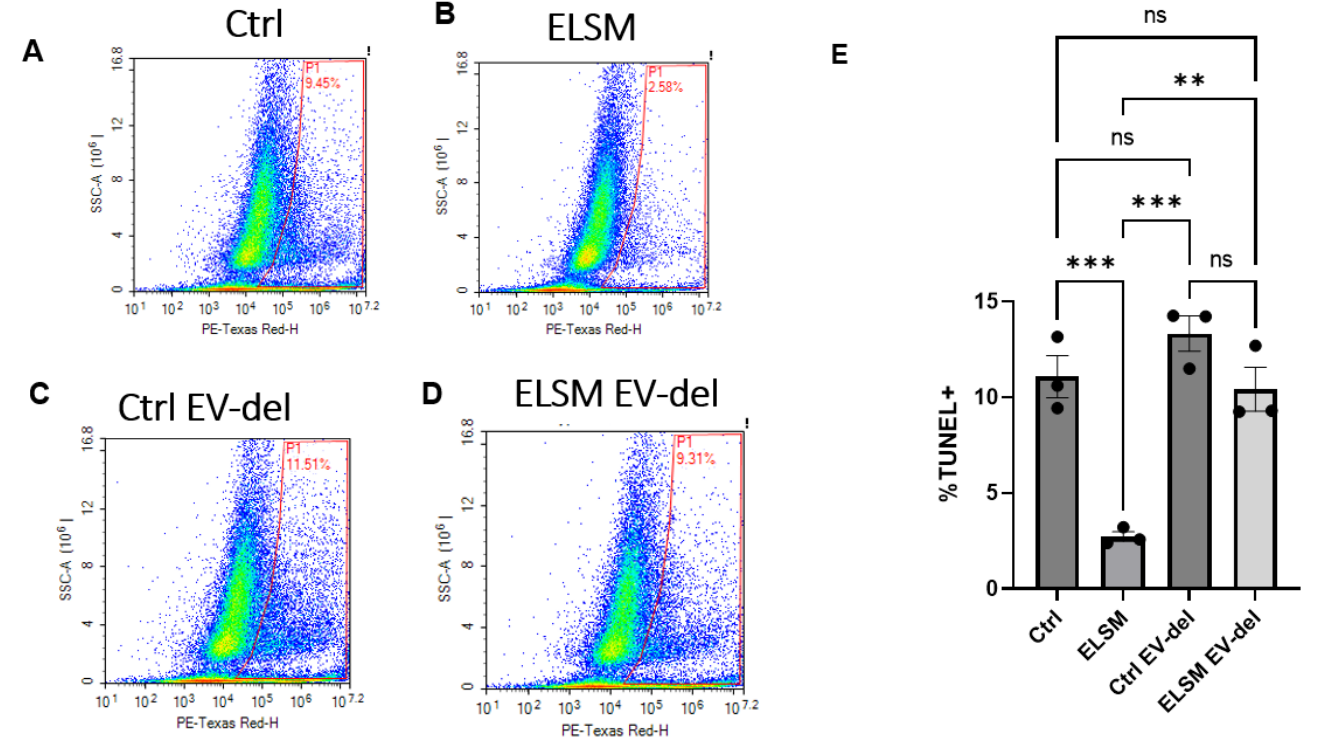
Figure 2. HL-1 cardiomyocytes treated with CM from ELSM-treated C-MSC showed reduced hypoxia-induced apoptosis, as determined by TUNEL staining and flow cytometry. ( A , B ) percentage of TUNEL positivity in HL-1 cells treated with CM from C-MSC Ctrl or C-MSC ELSM ; ( C , D ) percentage of TUNEL positivity in HL-1 cells treated with EV-depleted CM from C-MSC Ctrl or C-MSC ELSM ; ( E ) statistical analysis of the percentage of TUNEL-positive cardiomyocytes in the 4 groups (ns not significant; ** p < 0.01, *** p < 0.001, n = 3).